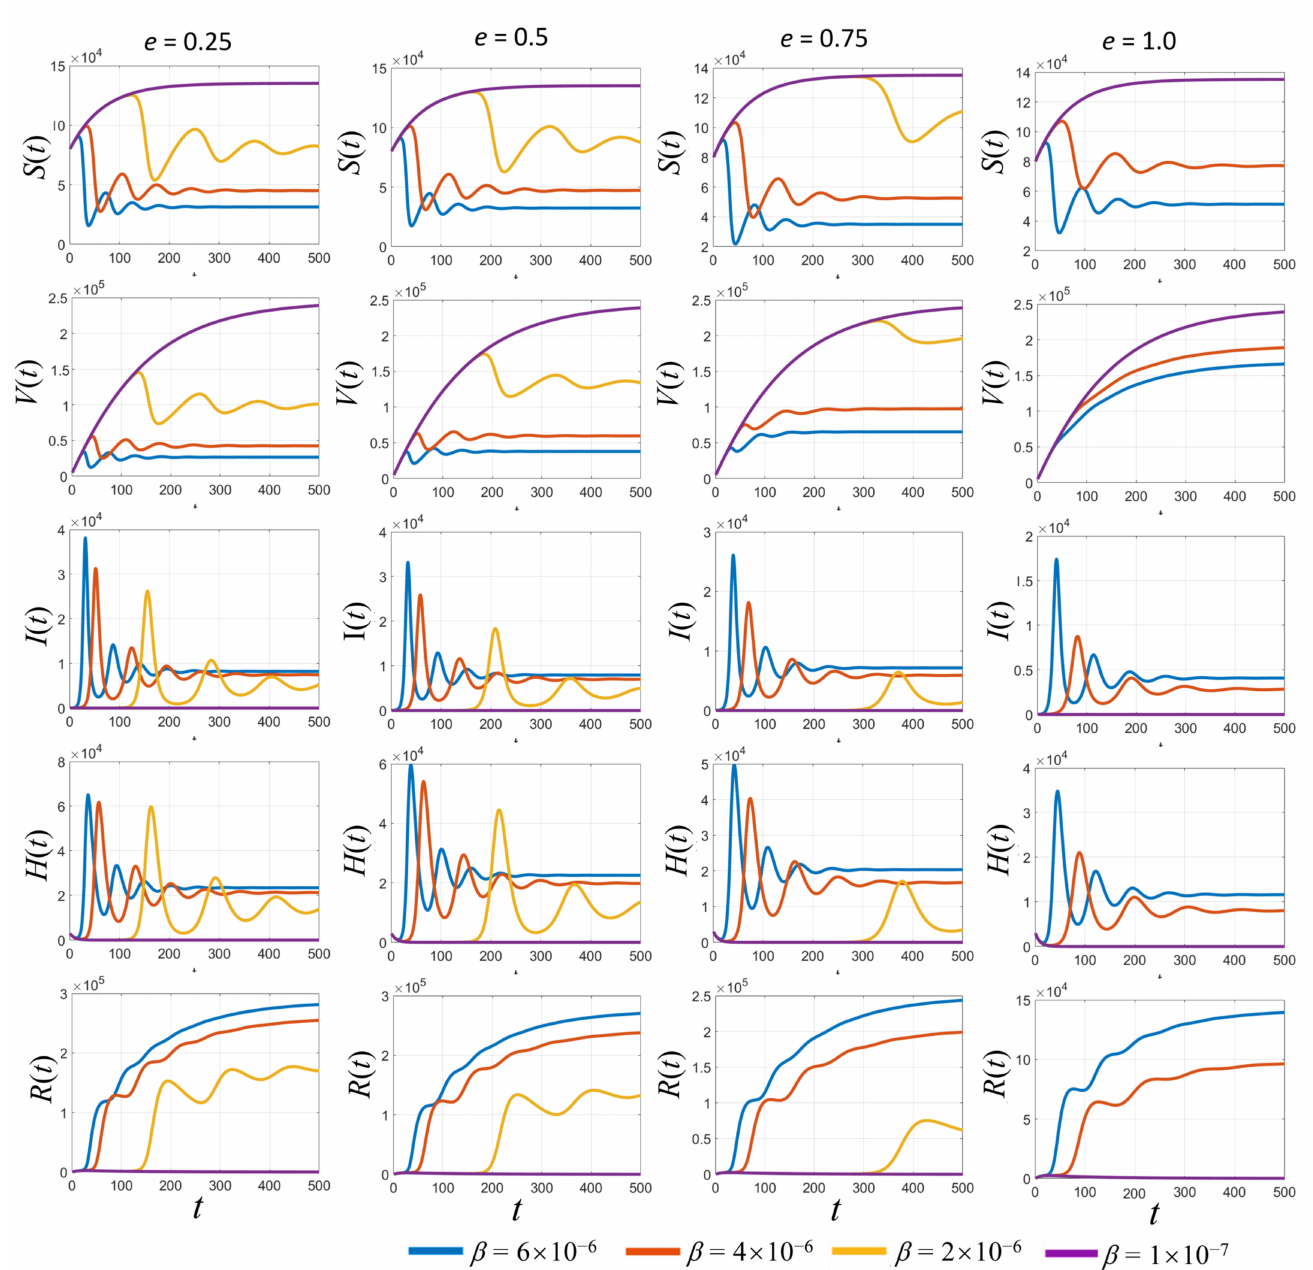
Figure 4. Simulated results of each population with different values of vaccine efficacy ( e ) and various transmission rates ( β